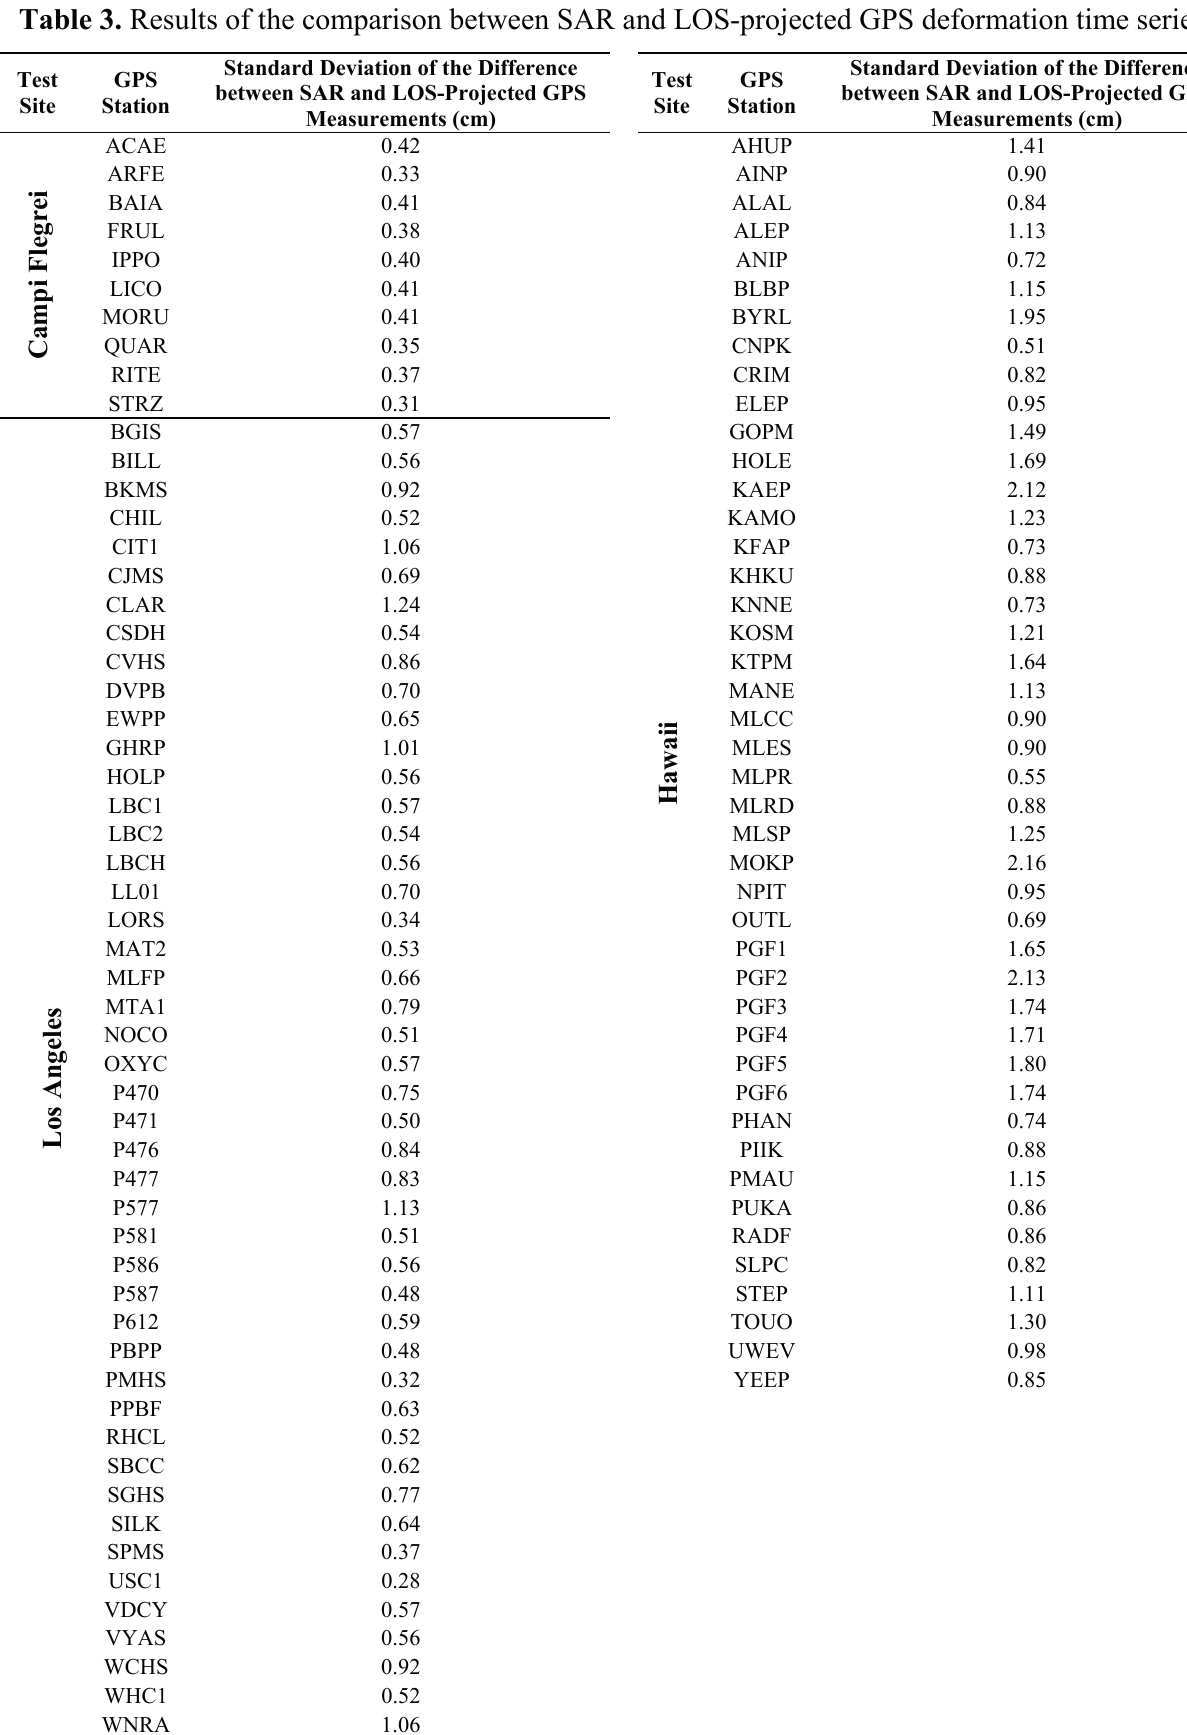
Table 3. Results of the comparison between SAR and LOS-projected GPS deformation time